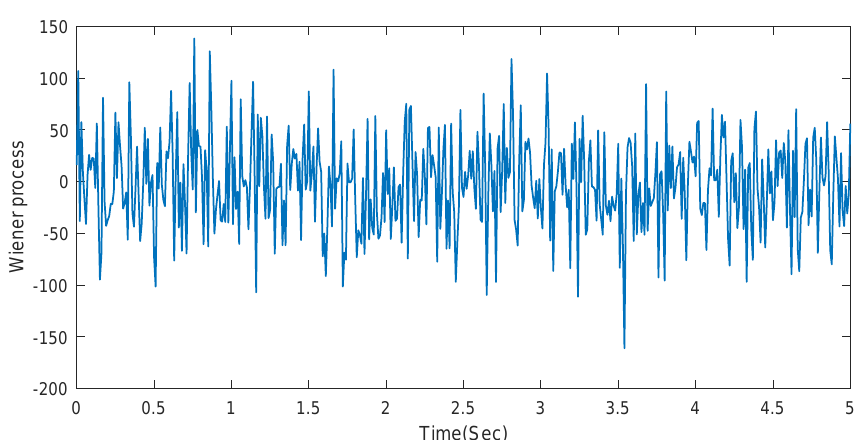
Figure 2. The response of the closed-loop system (53)–(56).